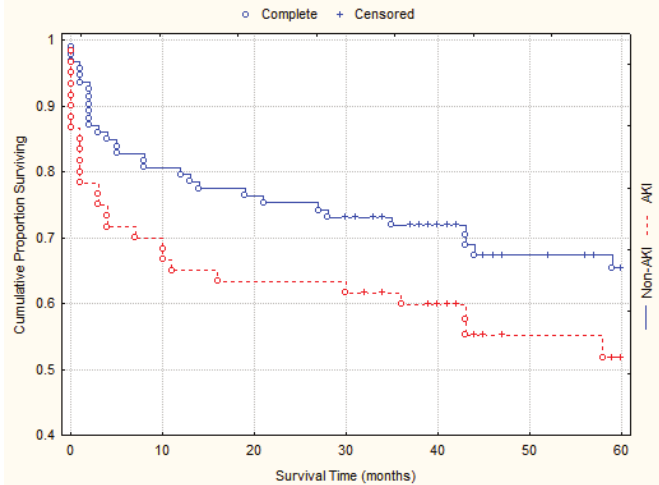
FIGURE 2 - Kaplan-Meier analysis of patients stratified according to development of acute kidney injury. Log-rank test did not show statistically significant difference between patient survival at 5-years (51.4% vs. 65.3%; p=0.077).